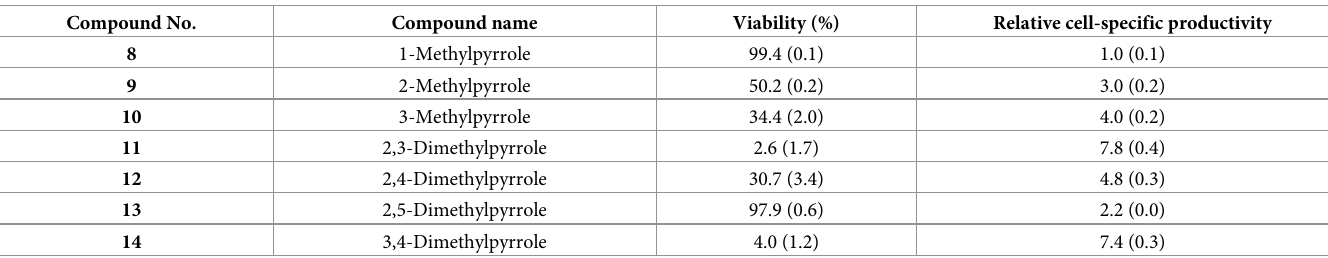
S1 Fig. The fed-batch culture profile in the retained glucose condition. Glucose was added on days 8 and 12 to keep the concentration above 1 g/L in the fed-batch cultures. And Feed medium was added on days 4, 6, and 8. Viable cell density ( A ), viability ( B ), glucose concentra- tion ( C ), lactate concentration ( D ), and mAb concentration ( E ) were measured every 2 days. The each slope of mAb concentration, consumed glucose concentration and lactate concentra- tion to integral viable cell concentration were used to indicate cell-specific productivity ( F ), cell-specific glucose uptake rates ( G ), and cell-specific lactate production rates ( H ), respec- tively [28]. S2 Fig. The trend of viability and cell-specific productivity in each pyrrole derivatives con- centration. Viability ( A ) and cell-specific productivity ( B ) were analyzed by sampling day 3 cells in the batch cultures. The tested pyrrole derivative concentrations were 0.08 to 0.64 mM in the culture solutions. Culture conditions were considered adequate when viability was above 80%. S1 Table. The validity of the first screening condition. DMSO was used as the 0% control, and 4-phenyl butyric acid dissolved in DMSO was used as the 100% control. Validity was eval- uated at the points of coefficient of variation (CV) using day 3 cell culture